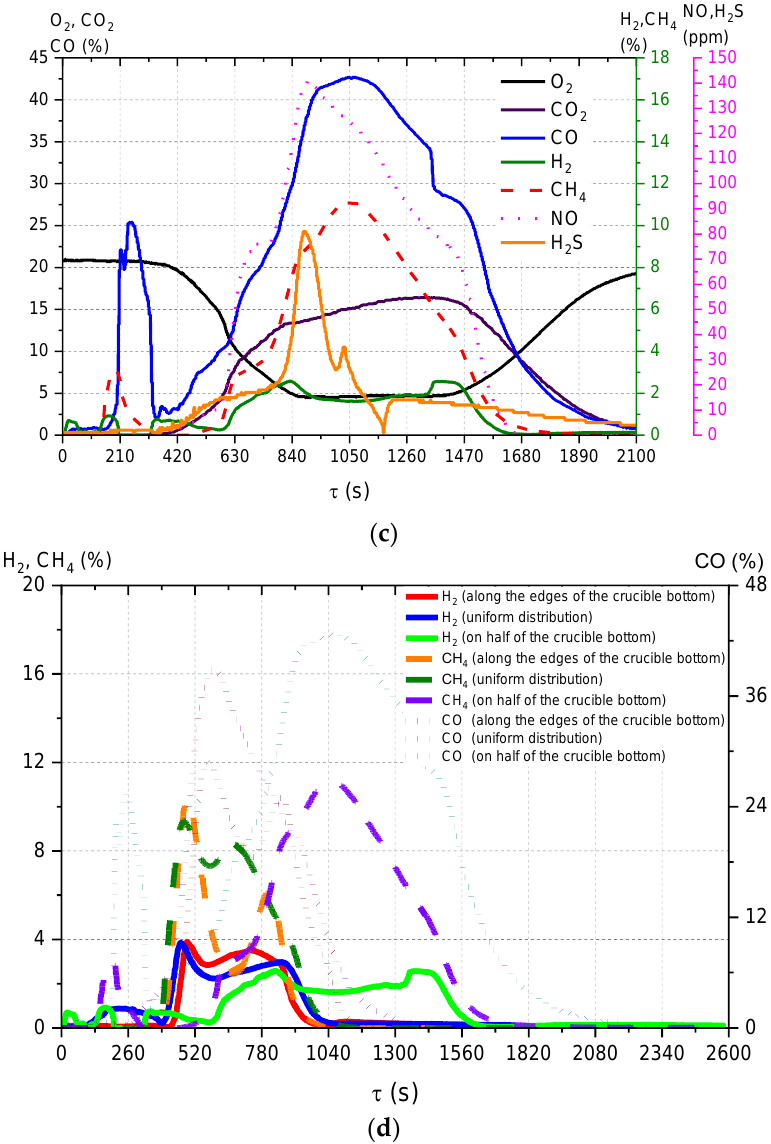
Figure 4. The concentrations of the components of the gas mixture with varying distribution of the sample in the crucible: along the edges ( a ); uniform distribution over the entire crucible bottom ( b ); on half of the crucible bottom ( c ); the comparison of concentrations of major gases ( d ).